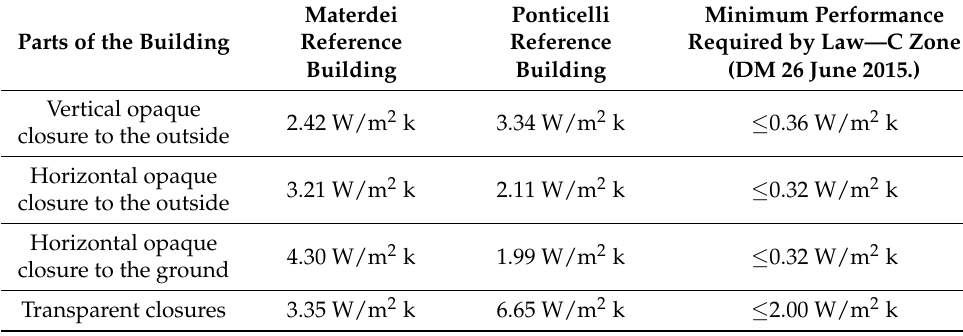
Table 1. The thermal transmittances of the parts of the building envelope for the two involved buildings.